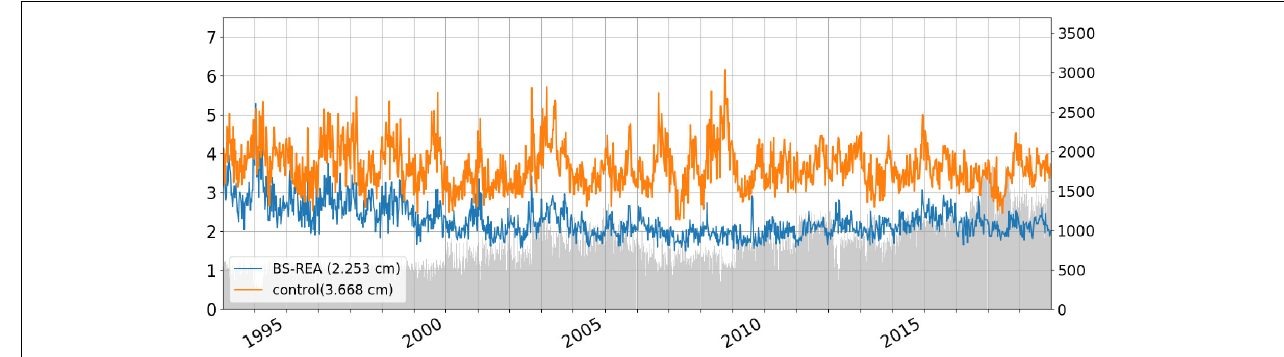
FIGURE 6 | Time series of sea level anomaly RMSD by considering the results of BS-REA (blue) and control experiment (orange) against sea level anomaly along-track observations in the Black Sea domain. The shaded area and the right axis correspond to the number of observations.